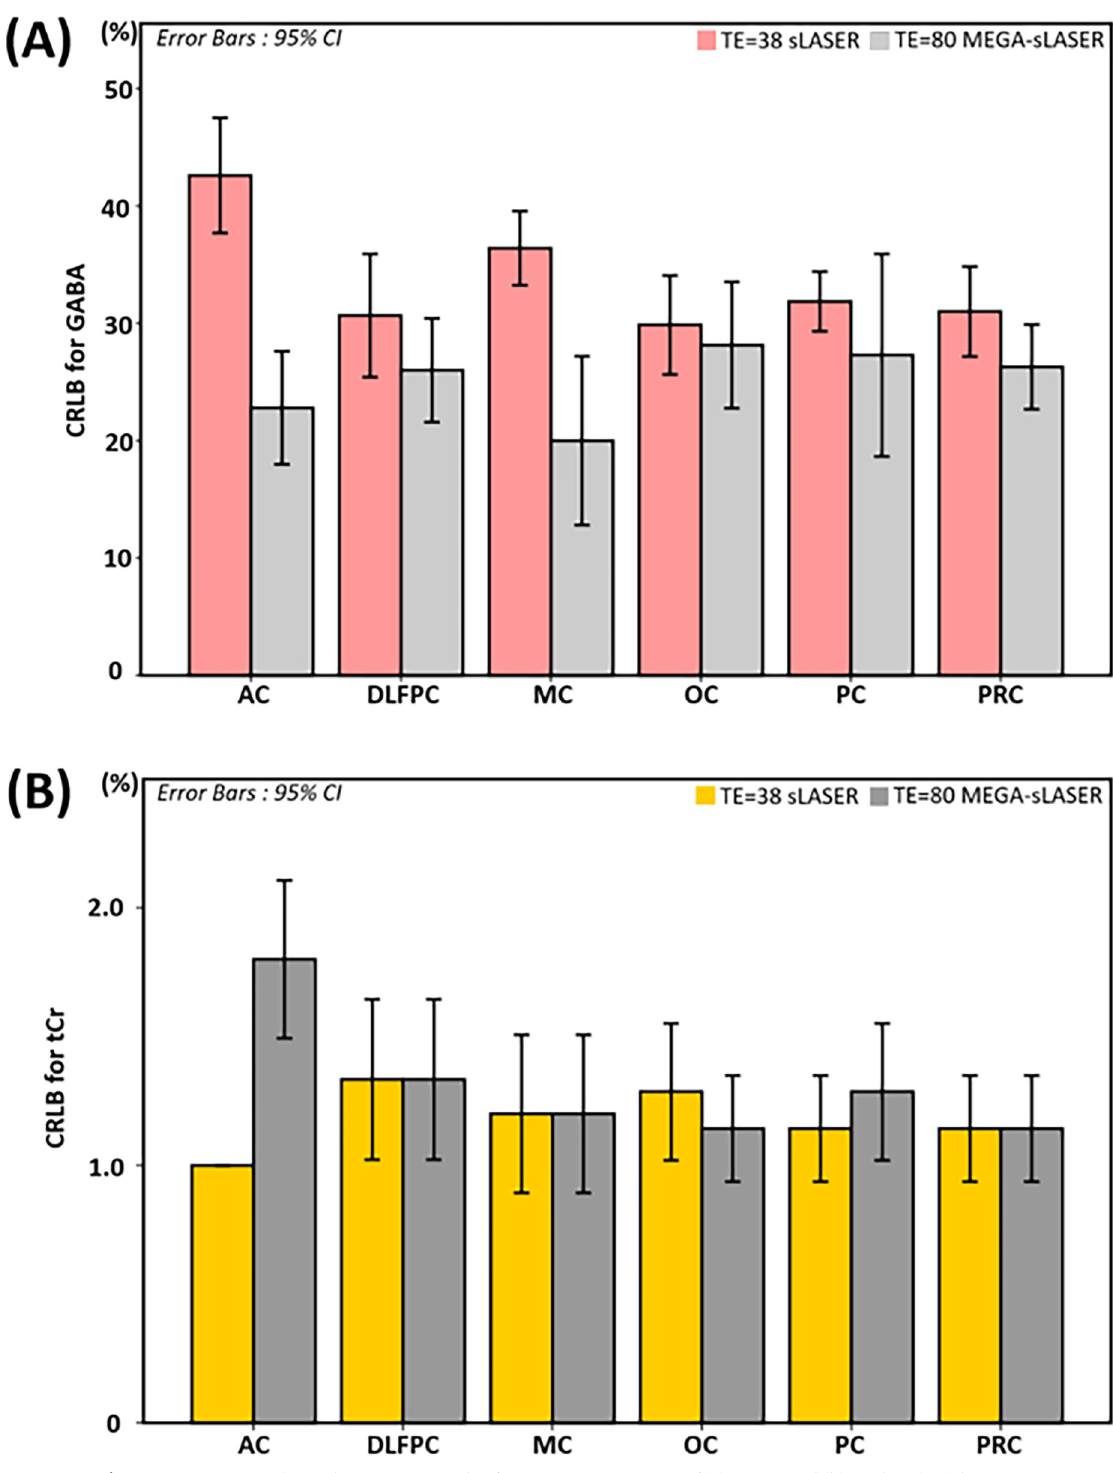
Fig 5. Crame´r–Rao lower bound (CRLB) comparison. This figure compares CRLBs of (a) GABA and (b) total Cr (tCr) between semi- LASER (sLASER) and MEGA-sLASER for the six brain regions examined. Error bars indicate 95% confidence intervals, in accordance with Table